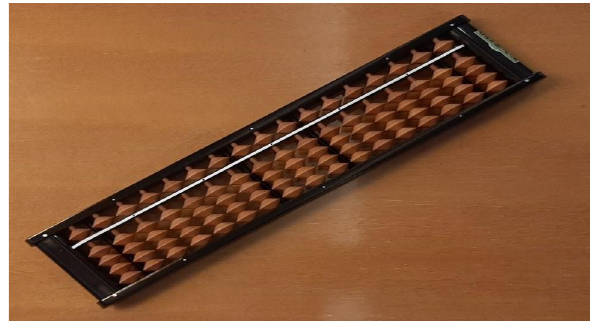
Figure 1. Image of the physical abacus, provided by the Instituto Supera de Educação, 2020.